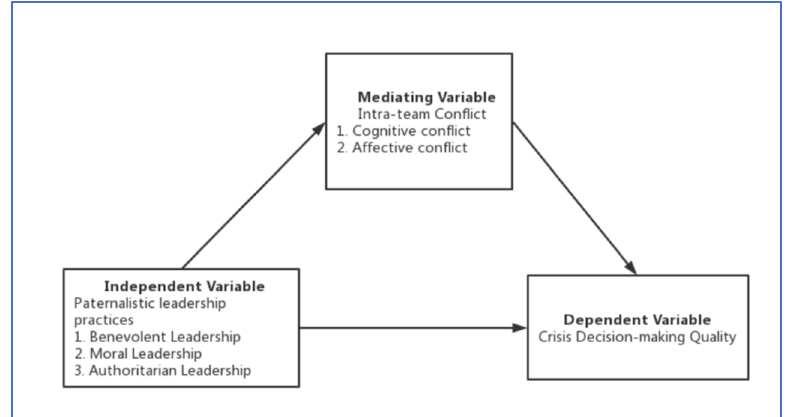
Figure 1. Theoretical and Conceptual Framework of This Study.